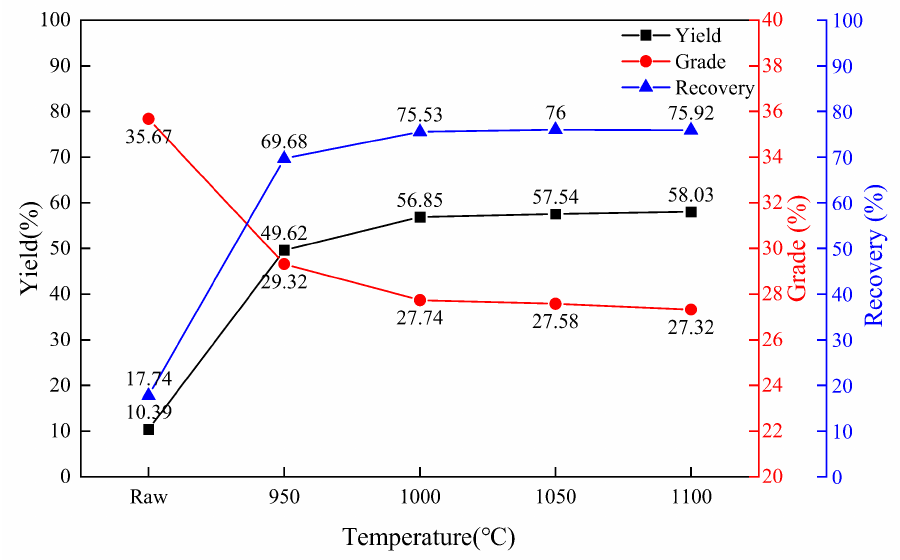
Figure 4. Magnetic separation effect between different oxidation temperatures at 75